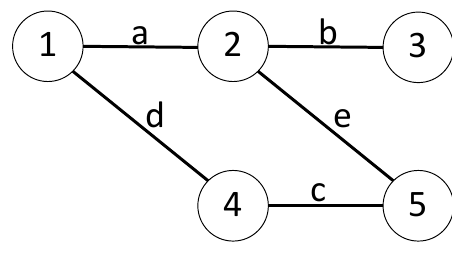
Figure 2. Undirected graph with its vertices are labeled with numbers and its edges with letters.